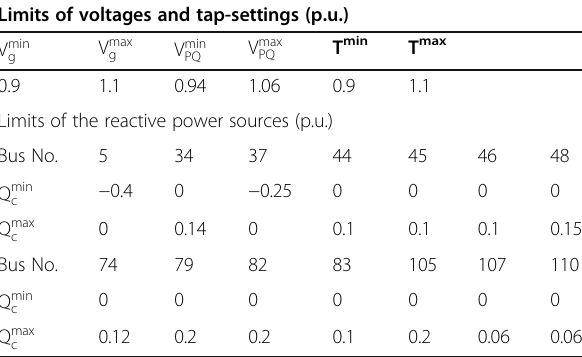
Table 9 Control variable limits (p.u.) for the test cases Limits of voltages and tap-settings